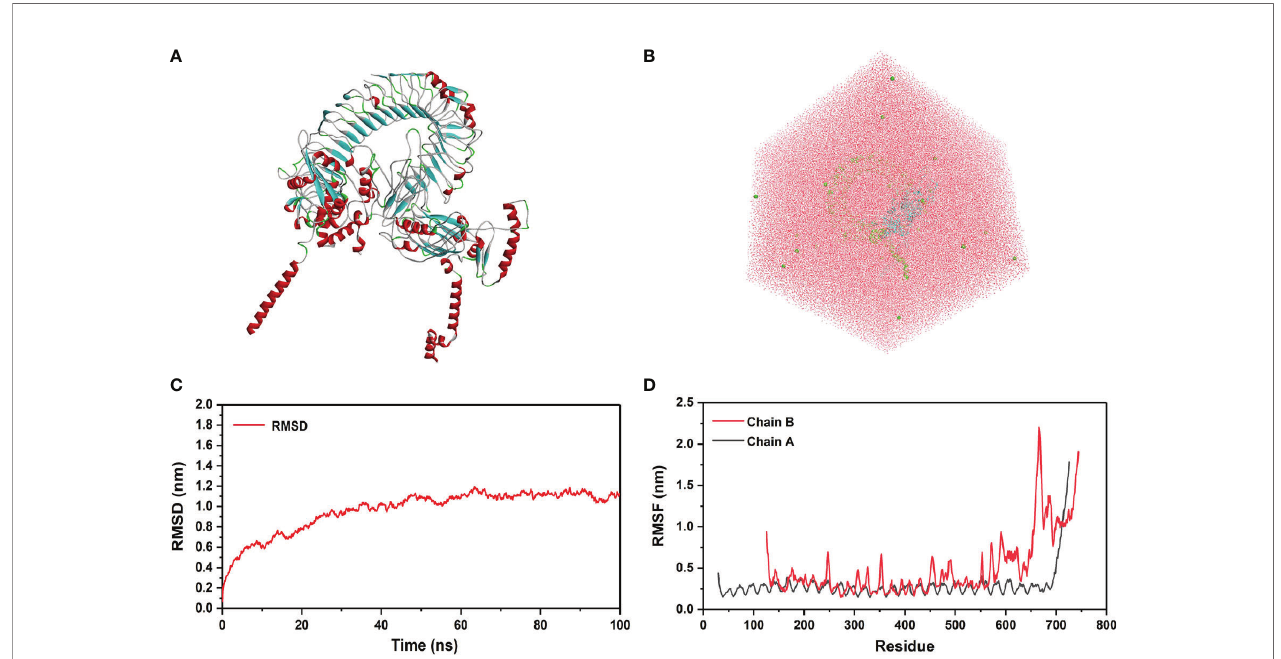
FIGURE 12 | Molecular docking of rSMEV with TLR-3. (A) This is a three-dimensional model of rSMEV and TLR-3 complex, and its color is displayed in the form of secondary structure style. (B) This is the rectangular box of TIP3P waters, and it extends up to minimum cutoff of 15 Å from the protein boundary. After molecular docking, the best-docked system was solvated in it. (C) This is the RMSD running diagram of MD simulation. The abscissa represents the running time of MD simulation, and the ordinate is the value of RMSD. (D) This is the RMSF running diagram of MD simulation. The chain A is TLR-3 and the chain B is rSMEV . The abscissa represents each amino acid residue in the complex, and the ordinate represents the RMSF value.